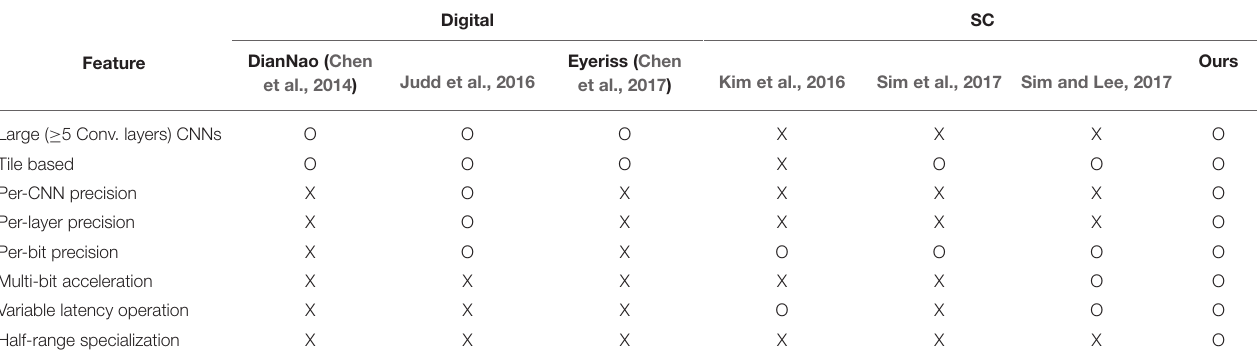
TABLE 3 | Feature comparison (O: supported, X: not